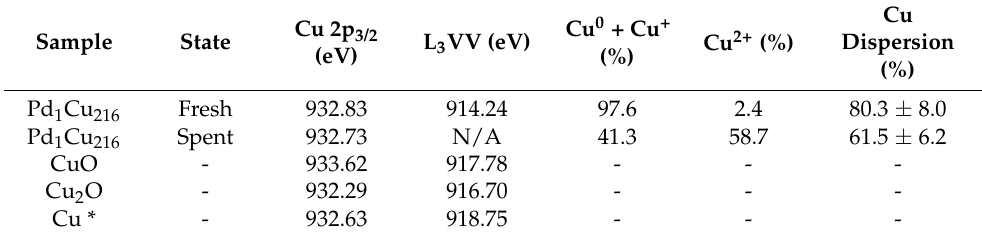
Figure 7. High-resolution stacked XPS and XAES spectra of the ( a ) Cu 2p and ( b ) Cu L 3 VV regions for the spent and unused Pd 1 Cu 216 catalyst together with the CuO Cu 2 O and Cu standards [11]. Table 4. XPS data summary. Binding energies for the Cu 2p 3/2 and kinetic energies of the Auger Cu L 3 VV transitions, surface composition and XPS calculated Cu dispersion for the unused and spent